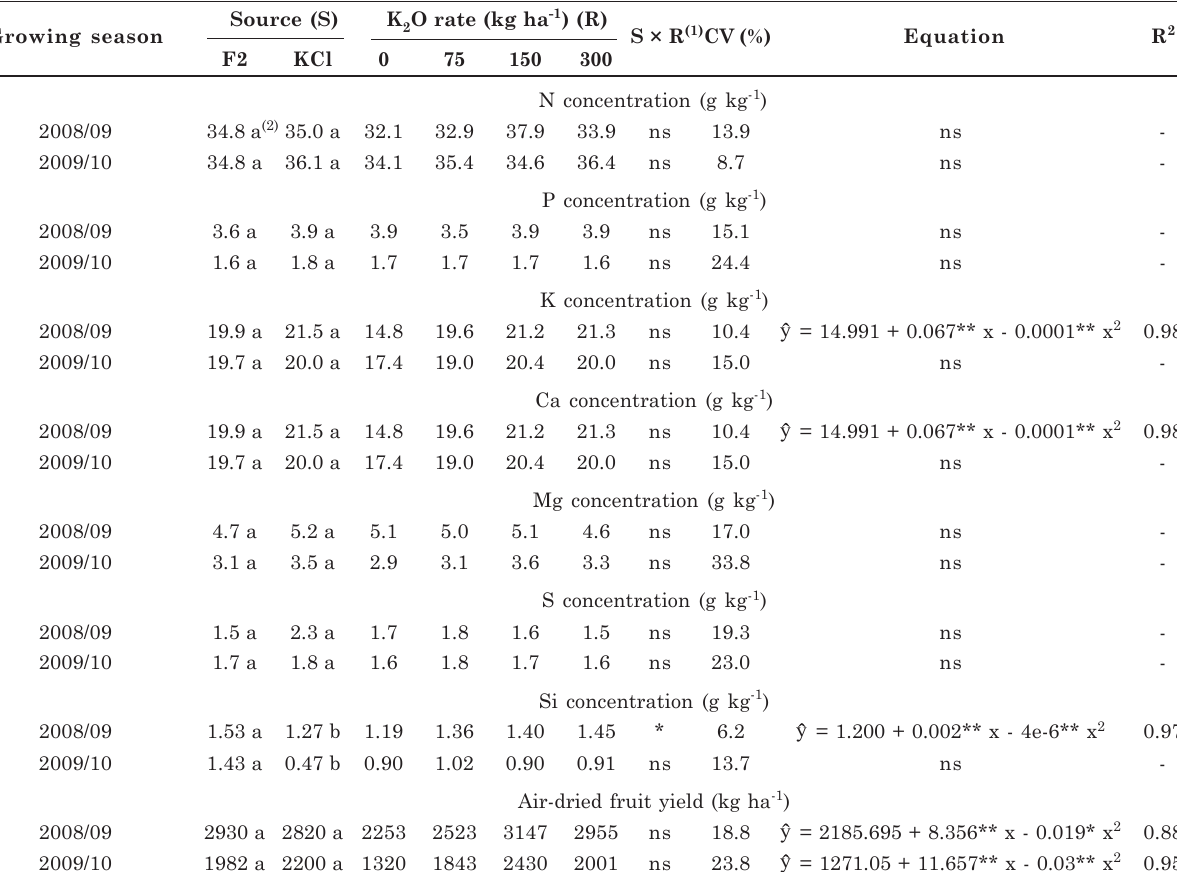
Table 1. Effect of sources and rates of potassium fertilization on concentration of N, P, K, Ca, Mg, S, and Si in the leaves and air-dried fruit yield of Arabica coffee Growing